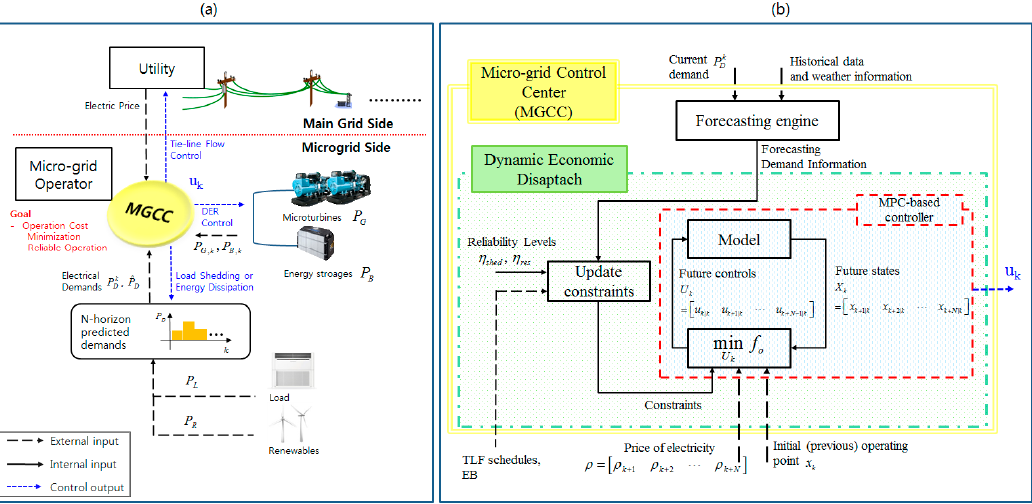
Figure 1. Model predictive control (MPC)-based operation structure in an interconnected microgrid (MG): ( a ) information flows; ( b ) block diagram of an MG central controller (MGCC). TLF: tie-line flow; EB: energy band; DER: distributed energy resources.